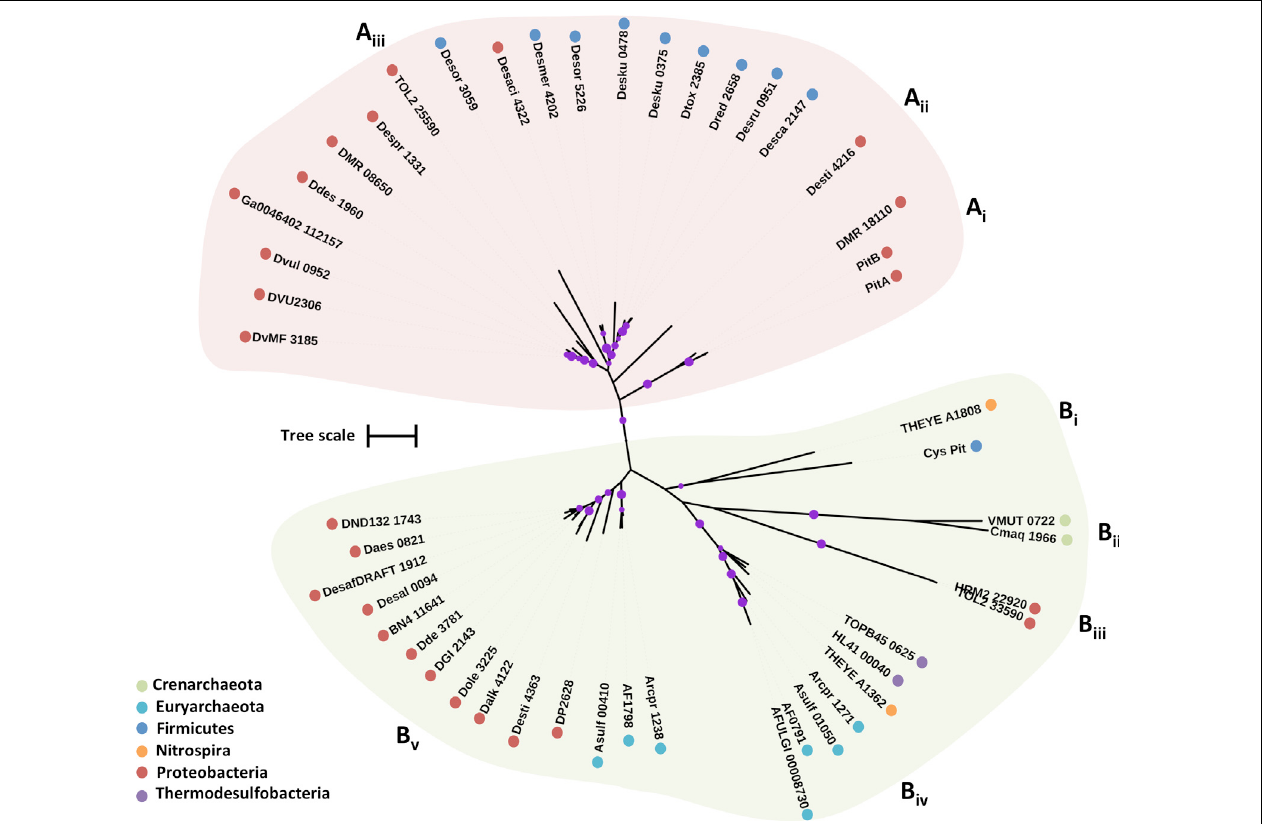
FIGURE 3 | Maximum likelihood phylogenetic tree of CysP protein sequences. The different protein clades are marked with different colored backgrounds and given a letter label (A,B) , while separate protein groupings are denoted by subscript numbering (i, ii, etc.). Phylum level classification of the protein sequences is indicated by colored dots next to the accession number (see Supplementary Table 1 for organism information). Reference sequences: PitA, inorganic phosphate transporter (UniProt P0AFJ7), PitB, inorganic phosphate transporter (UniProt P43676), Cys_Pit, sulfate transporter (BSUA_01689). Bootstrap values ≥ 50% are indicated by purple dots on each branch where the size of the dot is proportional to the value. The scale bar represents 1 substitution per amino acid